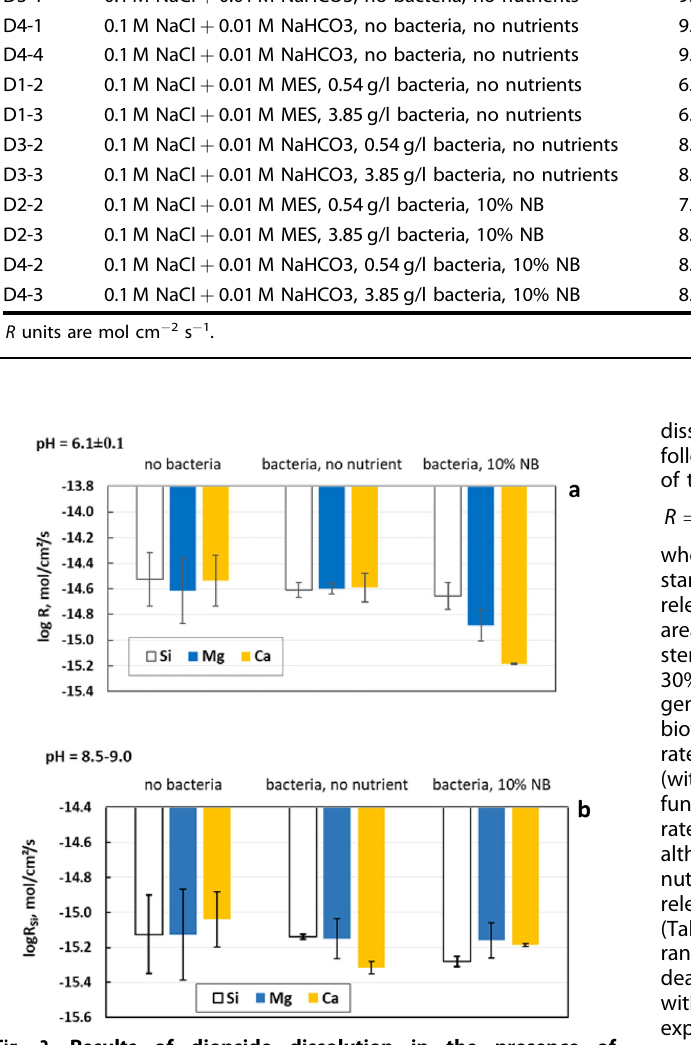
Fig. 2 Results of diopside dissolution in the presence of heterotrophic bacteria. Synthesis of obtained steady-state Ca, Mg, and Si release rates (average ± s.d.) from diopside at pH 6 ( a ) and 8.5 – 9.0 ( b ) with and without Pseudomonas reactans and in the presence or not of nutrients. The error bars represent average of 2 – 4 duplicates, each comprising 3 – 4 independent sampling at the steady